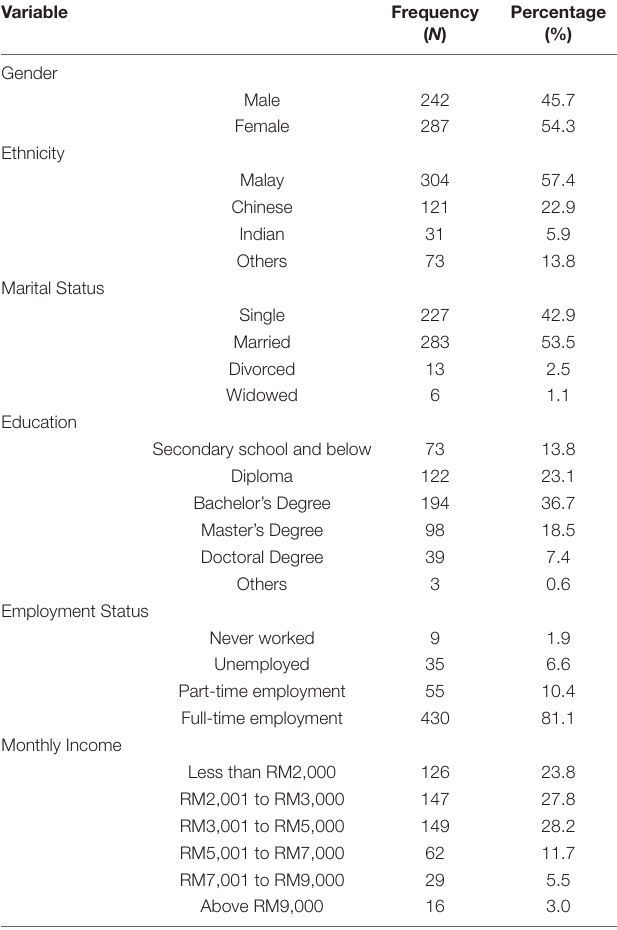
TABLE 1 | The characteristics of the respondents.